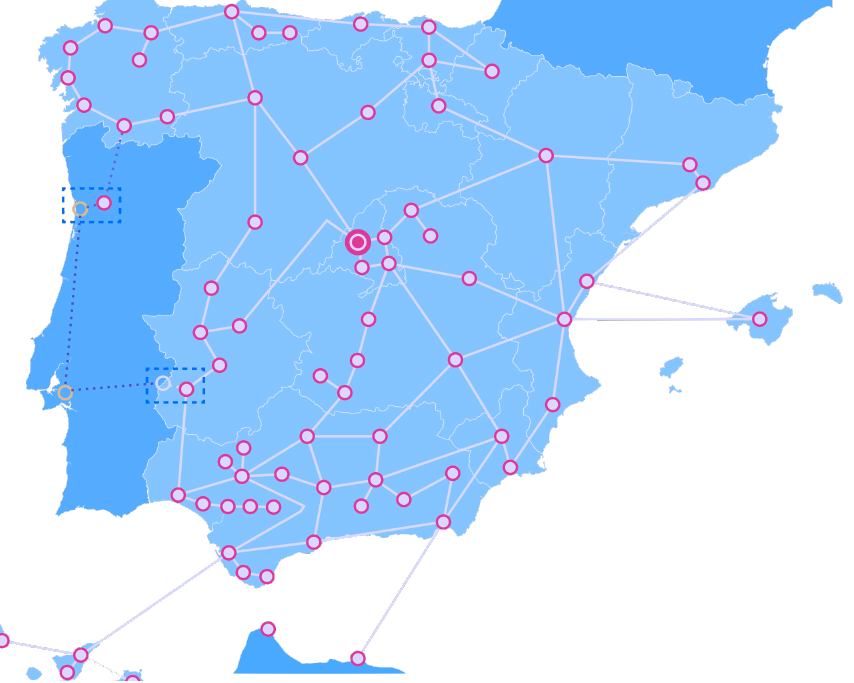
Figure 1. Representation of a network of quantum repeaters distributed over dark fiber nodes on the peninsular territory of Spain and the connection with its territories outside the European